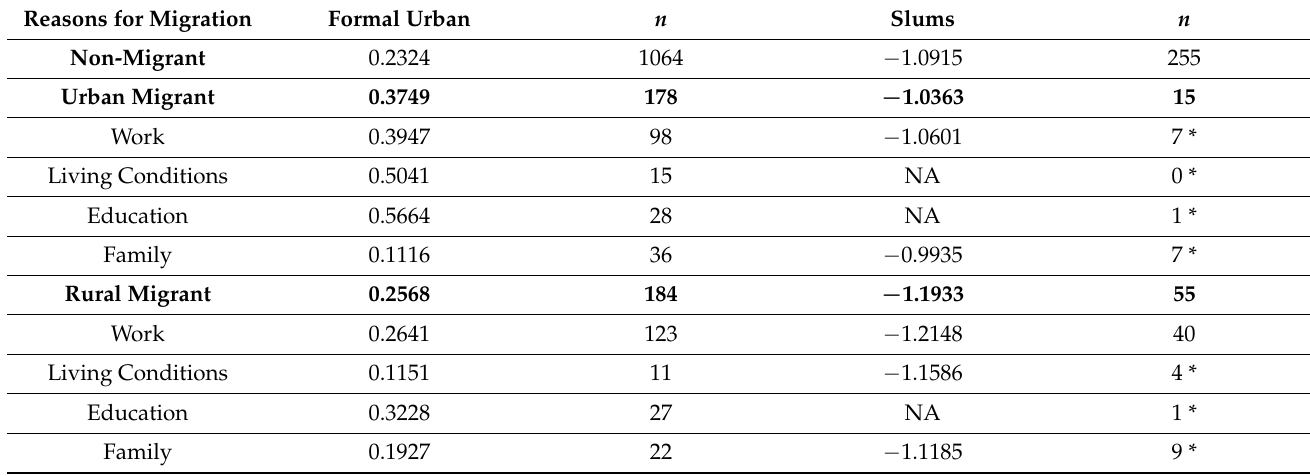
Figure 8. Resilience matrix displaying kernel density estimation of RCI of sub-groups based on the migration characteristic reasons for migration. Table 4. RCI of sub-groups based on the migration characteristic reasons for migration (* low sample